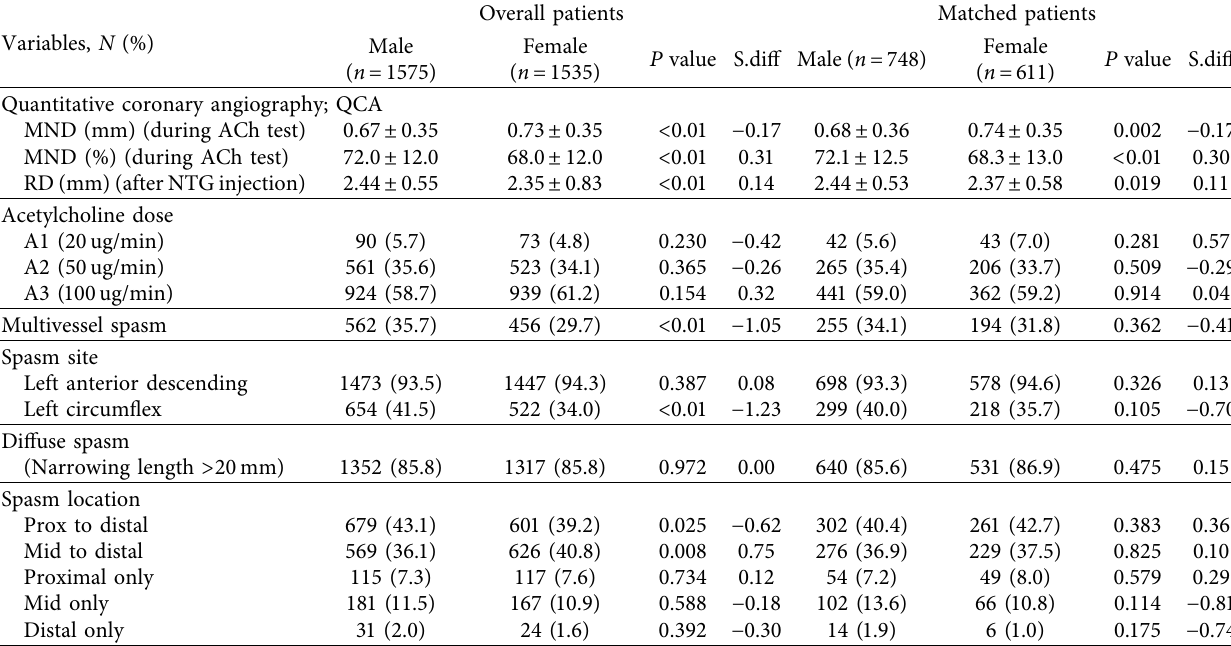
Table 3: Angiographic characteristics in patients with acetylcholine-induced coronary artery spasm.